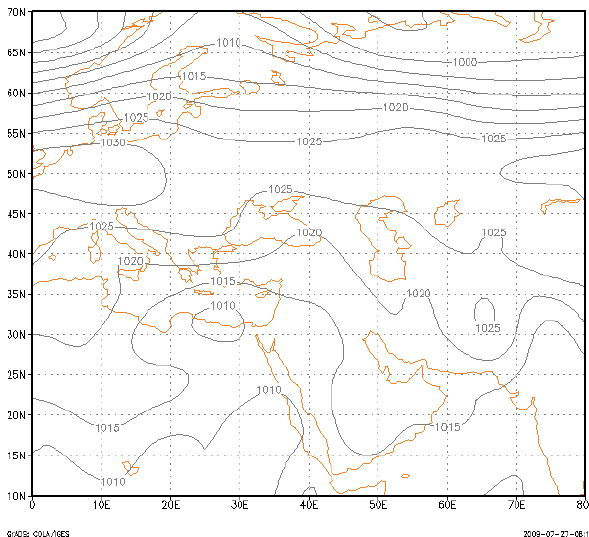
Fig. 3. The pattern of the geopotential heights and the position Fig. 2. The pattern of the surface isobars (AAXX) 48h before the of trough line at 500hPa level 48h before the rainfall (type I: rainfall (type I: 28 November 1986). Fig. 3 The pattern of the geopotential heights and the position of trough line at 500 Fig. 2 The pattern of the surface isobars (AAXX) 48 hours before the rainfall (Type I: 28 November Fig. 3 The pattern of the geopotential heights and the position of trough line at 500 Fig. 2 The pattern of the surface isobars (AAXX) 48 hours before the rainfall (Type I: hPa level 48 hours before the rainfall (Type I: 28 November 1986) 28 November 1986) hPa level 48 hours before the rainfall (Type I: 28 November 1986) 28 November 1986)